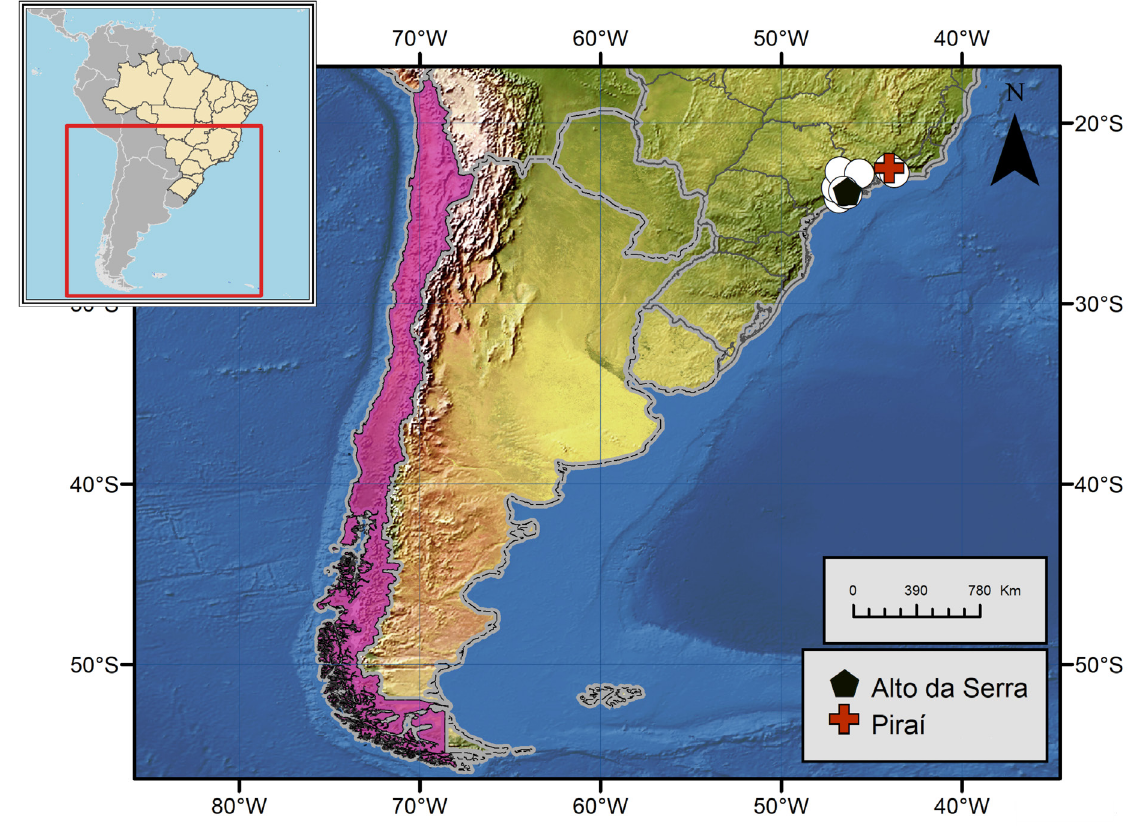
Fig. 14. South America, showing the distribution of the Lacronia nigra (B. Soares, 1942) comb. nov. non-type specimens (as white circles). The legend refers to the type localities of Discocyrtus niger B. Soares, 1942 (Piraí) and Discocyrtus rarus B. Soares, 1944 (Alto da Serra). The area shaded in magenta represents Chile, the type locality of Discocyrtus fazi Piza,